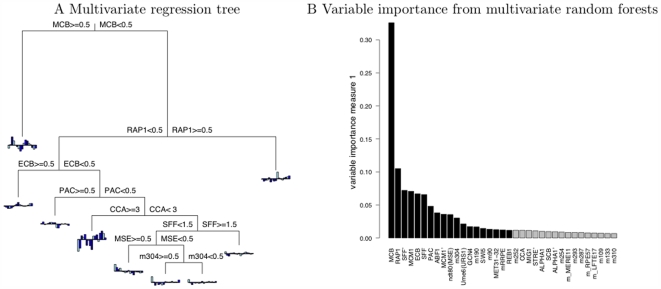
A Multivariate regression tree and the variable importance measures from MRF for the cell cycle data.Panel A illustrates a multivariate regression tree built for the cell cycle data, in which allowable splits are order-preserving motif counts and the splitting values are mid points of two consecutive motif counts. The first split separates MCB counts at 0.5, resulting in genes that have at least one copy of the MCB motif (≥0.5) going into the left daughter node whereas genes that don not have the MCB motif (<0.5) going into the right daughter node. Tree is pruned to the size that has the lowest cross validation error. At each leaf node resides a barplot that indicates the average expression level at each time point of genes allocated to the node. Panel B shows the barplot of the variable importance measures yielded by multivariate random forests (MRF). Black bars are those that have significant (FDR adjusted ) based on the permutation procedure that randomizes the relationship between expression and motif counts. Names of putative motifs begin with the letter “m”.